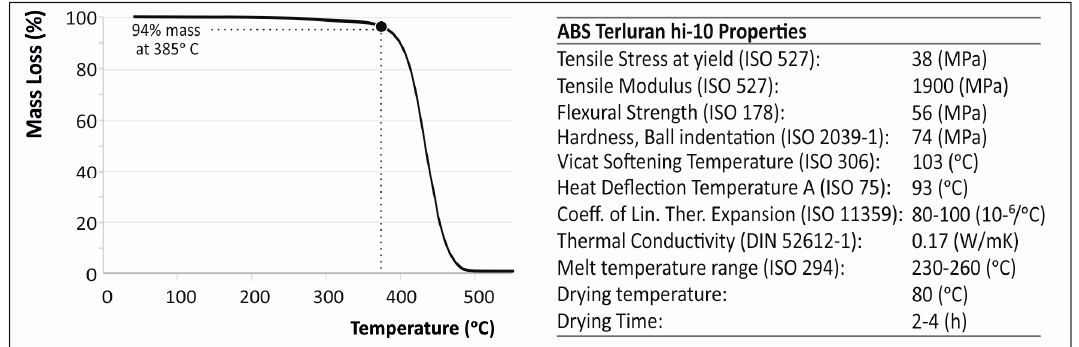
Table 1. T g and relaxation temperatures for materials studied.